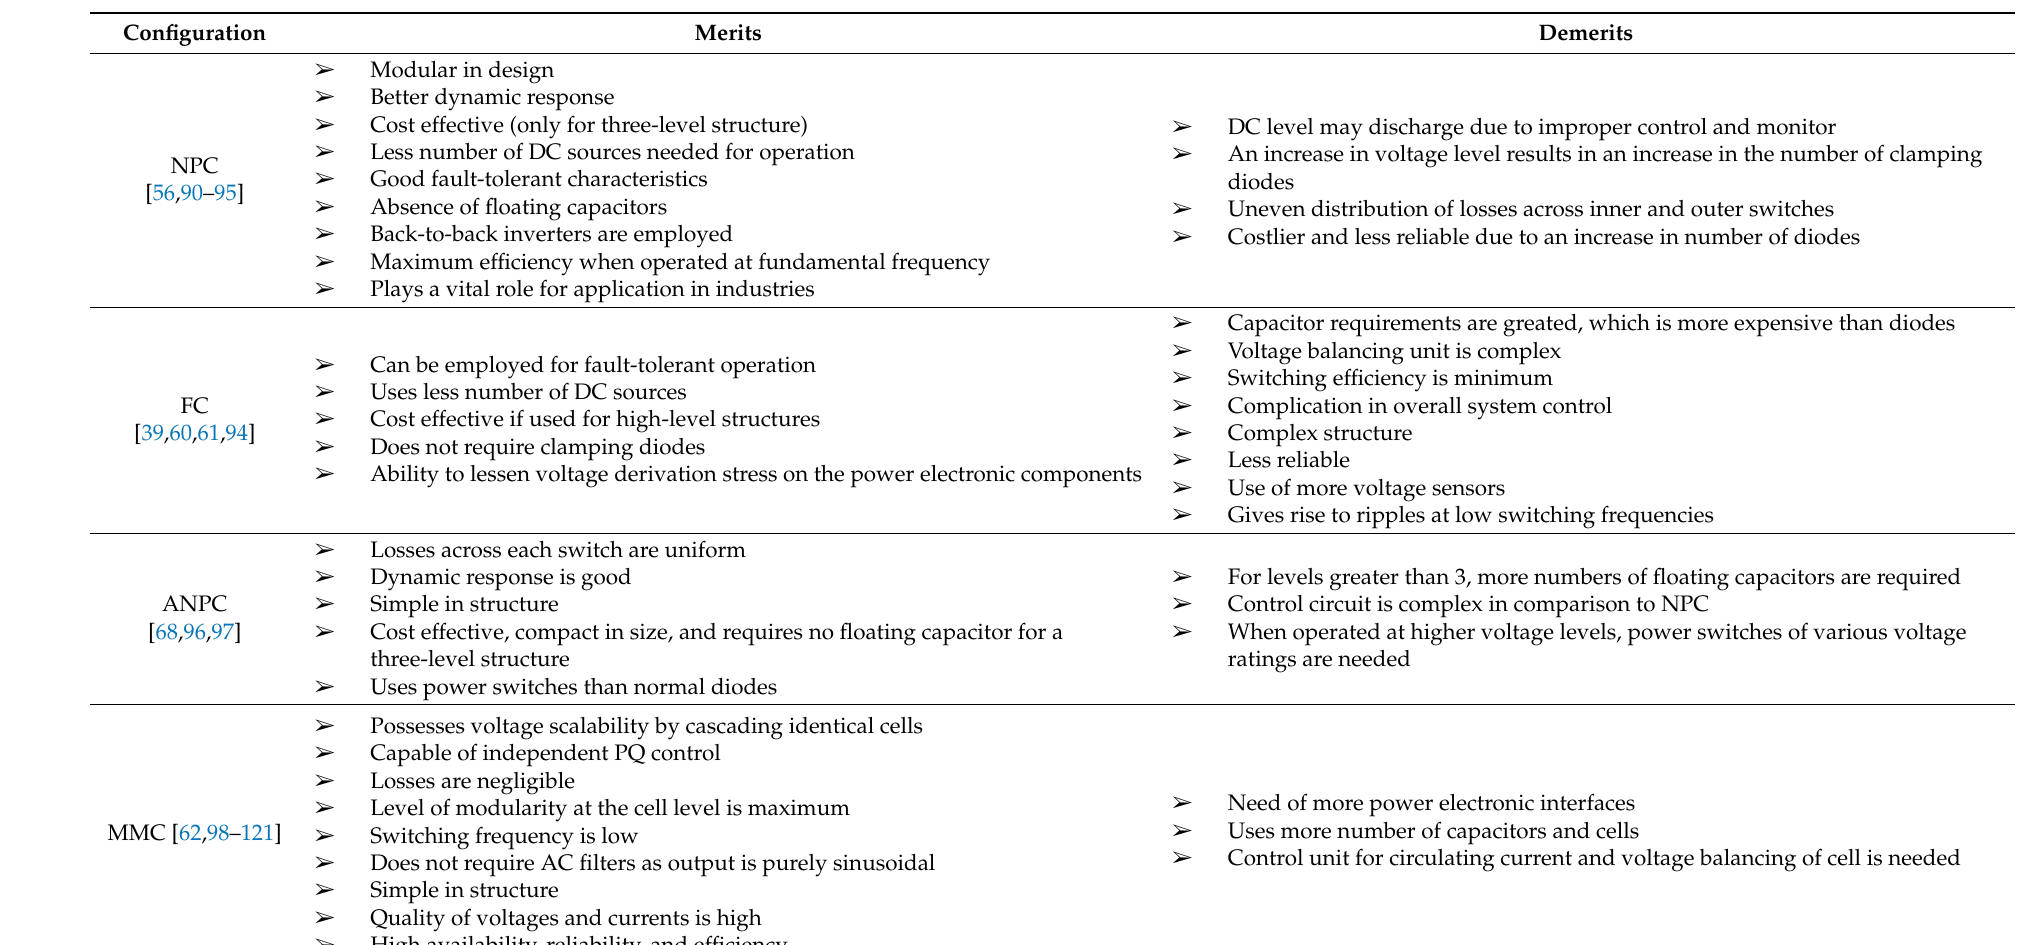
Table 2. A comprehensive summary of merits and demerits of various MLI configurations.